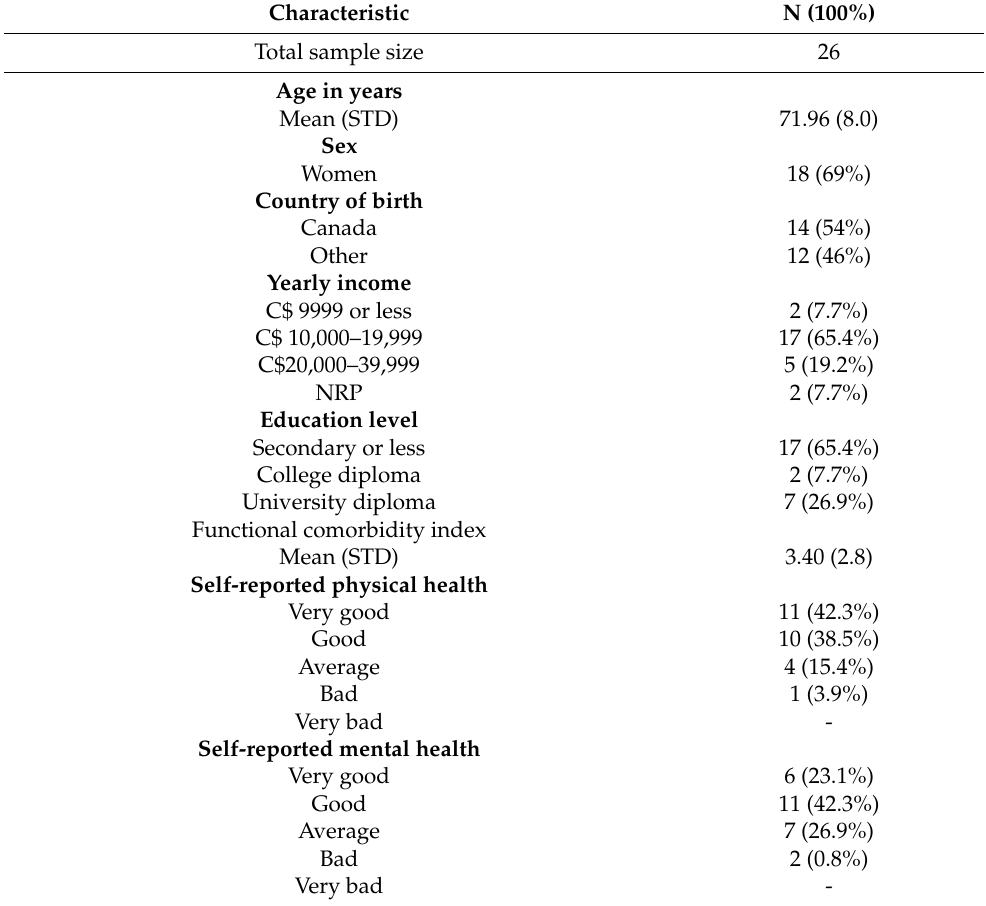
Table 2. Sociodemographic and perceived health characteristics of 26 older public housing